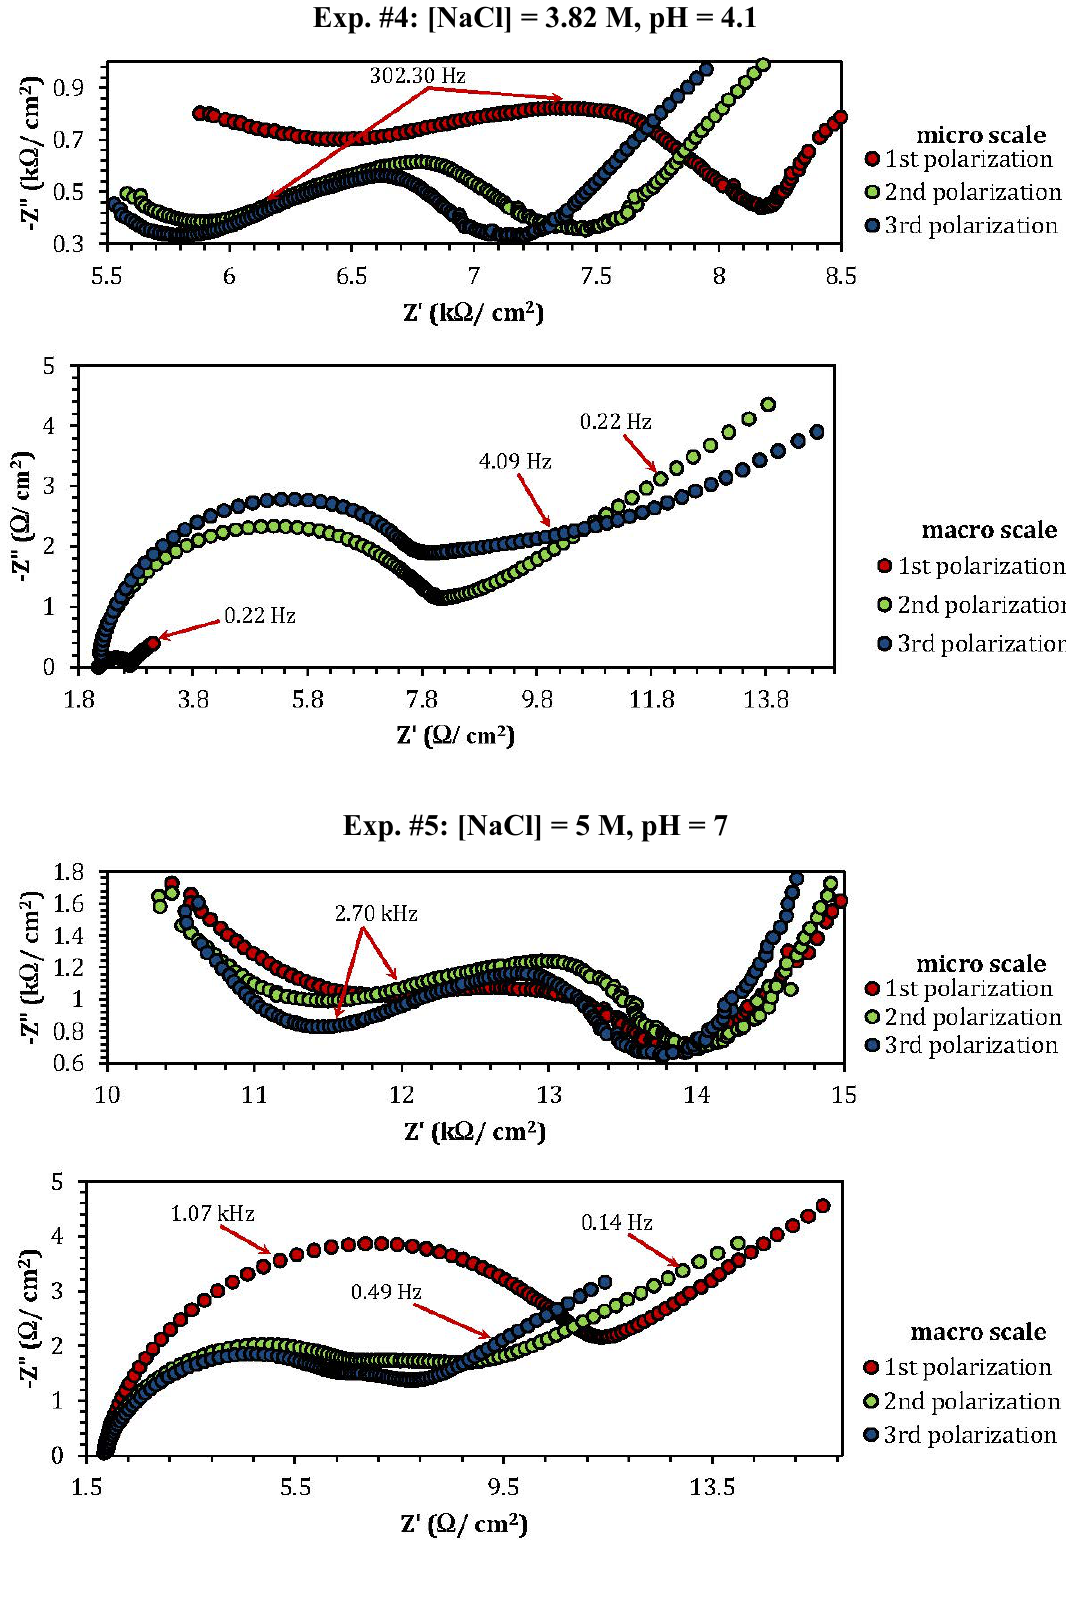
Figure 7. Cont. Exp. #4: [NaCl] = 3.82 M, pH = 4.1